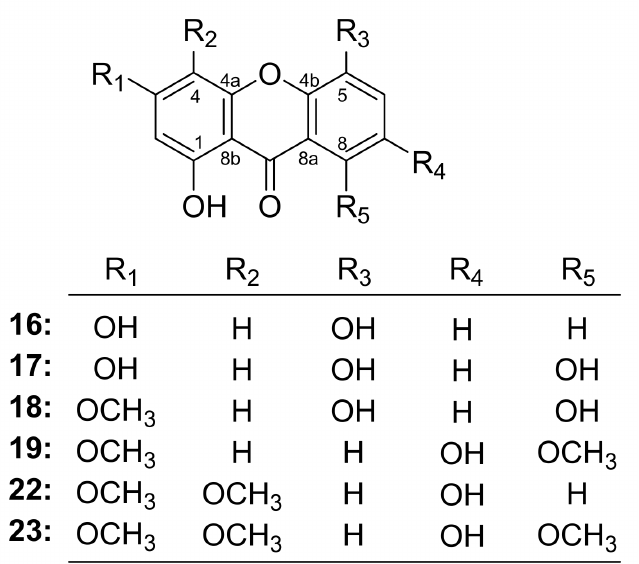
Figure 4. The structures of xanthones 16 – 19 , 22 and 23